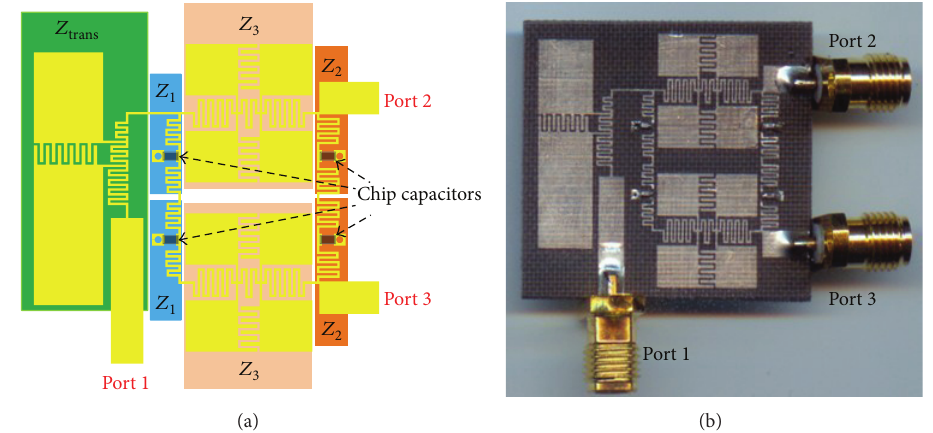
Figure 8: Layout and photo of the proposed two-section half-wave balun.